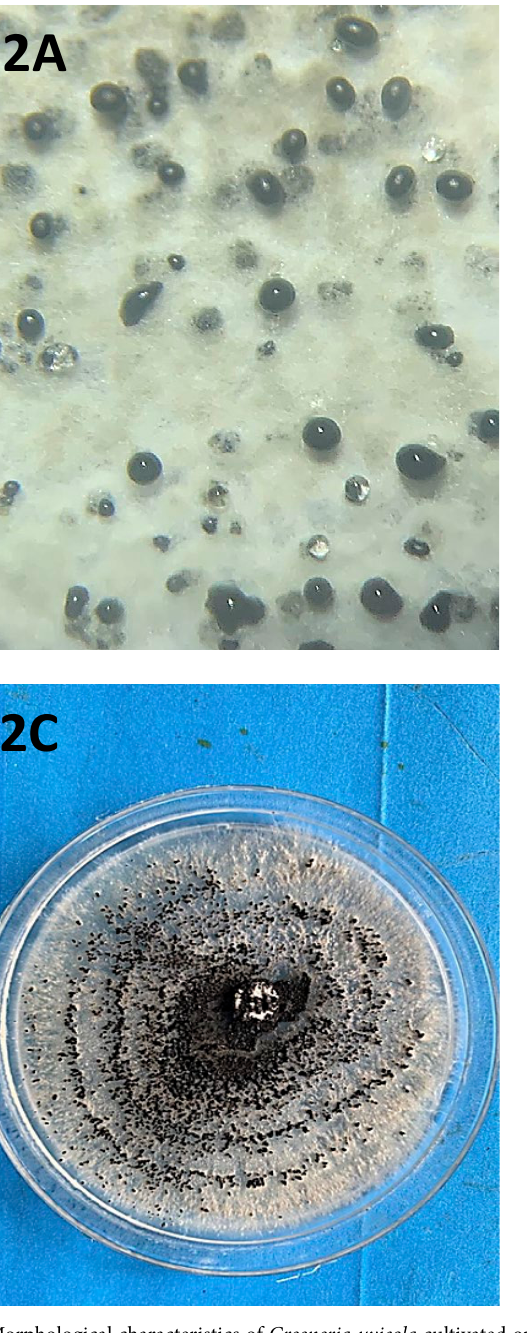
Figure 2. Morphological characteristics of Greeneria uvicola cultivated on PDA. 2A: Conidiomata growing over mycelium 2 d after inocula- tion. 2B: Mature, opaque and deformed acervuli. 2C; Petri dish covered with mycelia, showing concentric rings of multiple conidiomata at 7 d after inoculation. 2D. Morphology of conidia. Scale: each division = 2.5